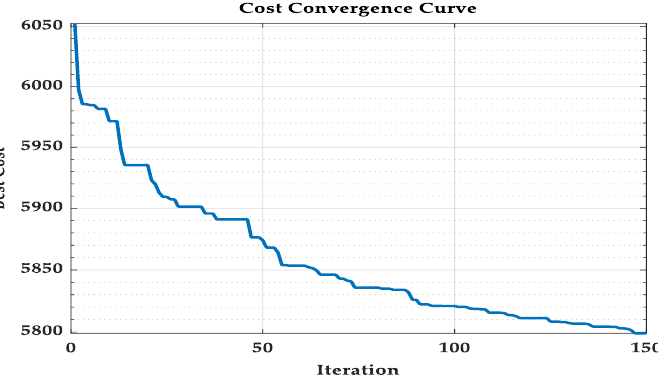
Figure 14. Cost convergence curve.